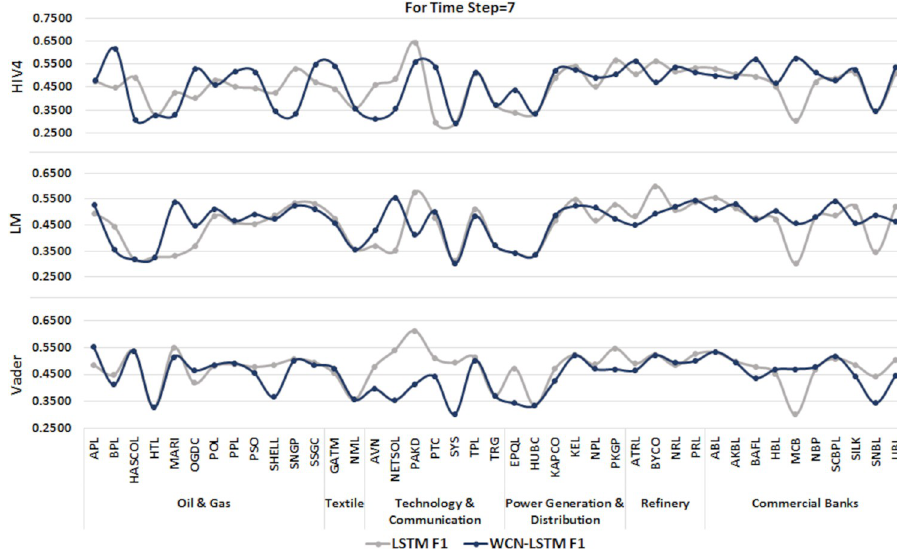
Fig 7. F1-score of prediction models by incorporating information from the last 7 days using the test